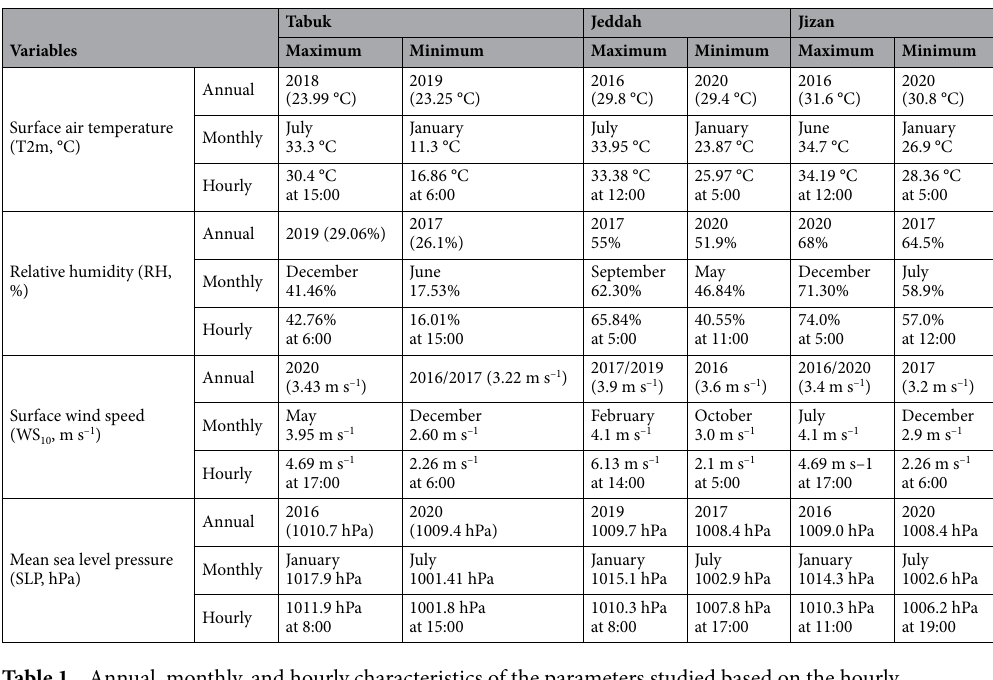
Table 1. Annual, monthly, and hourly characteristics of the parameters studied based on the hourly observation data (2016–2020) in Tabuk, Jeddah and Jizan.